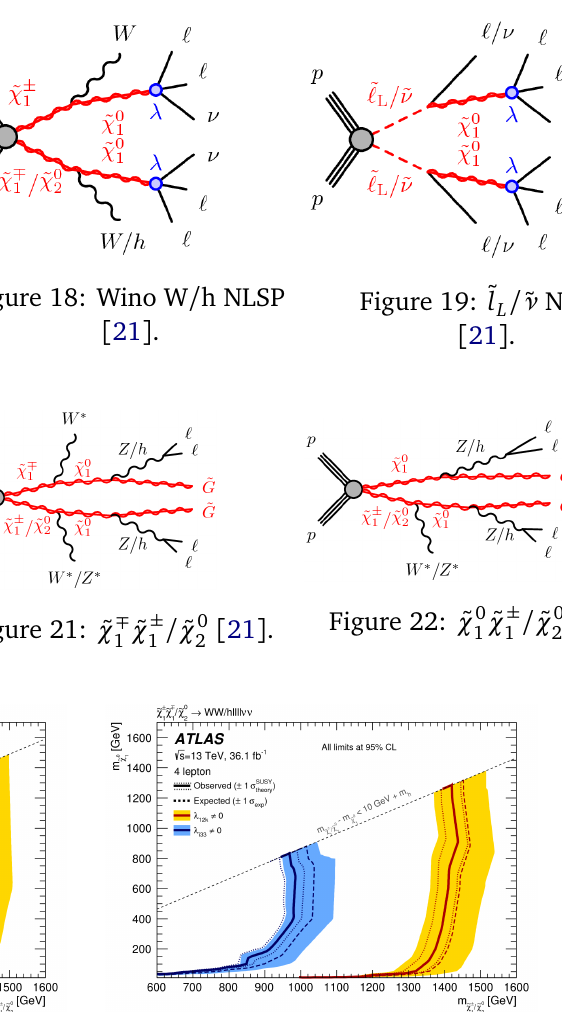
Figure 17: Wino W / Z NLSP